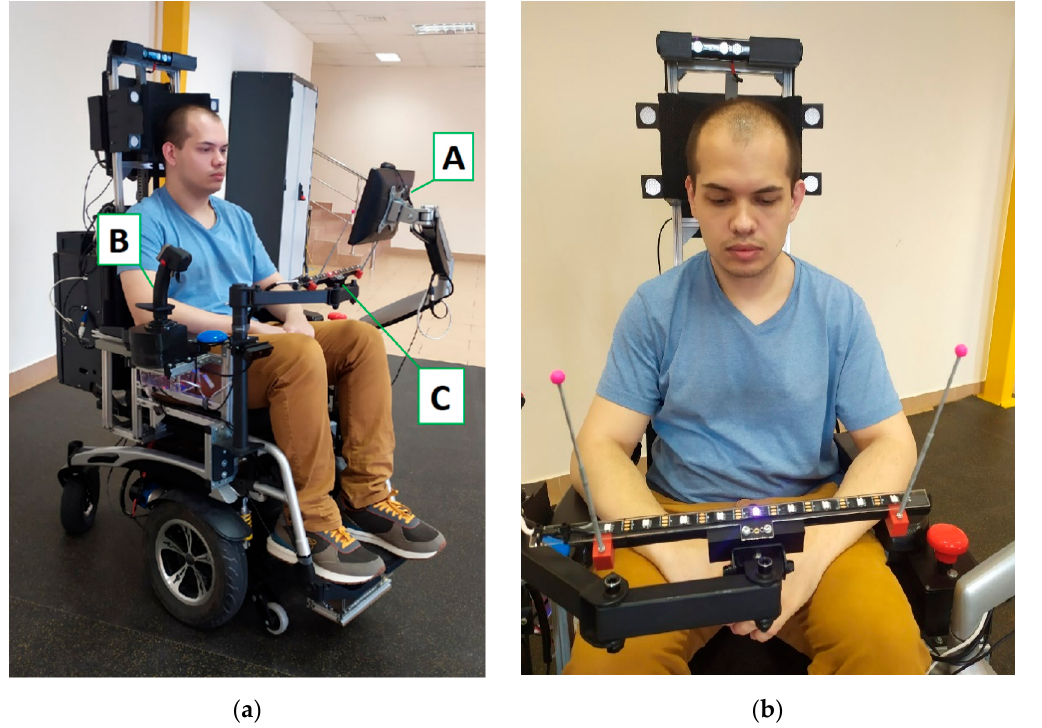
Figure 1. ( a ) A photo of the robotic wheelchair with the experimenter, here in a role of a participant. A—a touch monitor used to give distance estimates and sense of agency scores, B—a flight simulator joystick used to steer the wheelchair, C—LEDs involved in Experiment 2; ( b ) a participant looking at the central LED during control conditions.